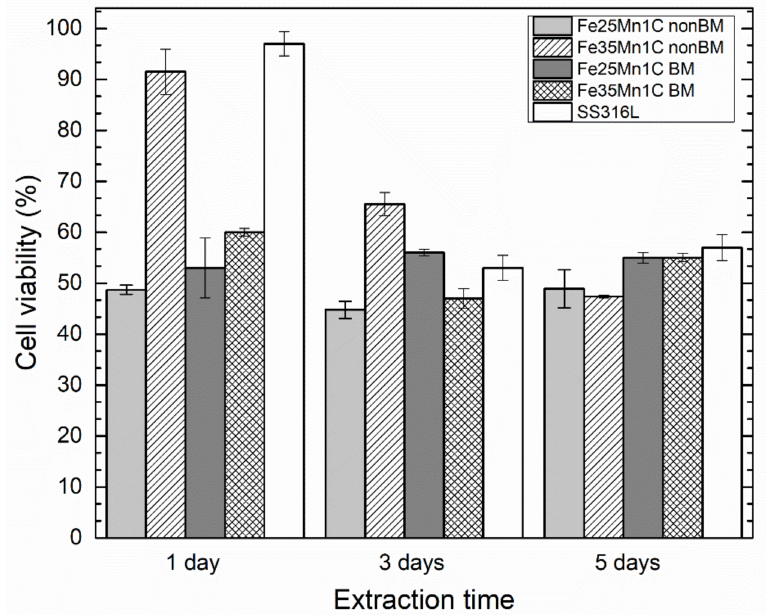
Figure 8. Results of cell viability test upon incubation for 72 h. All samples were extracted upon immersion from 1 day to 5 days before the cell viability